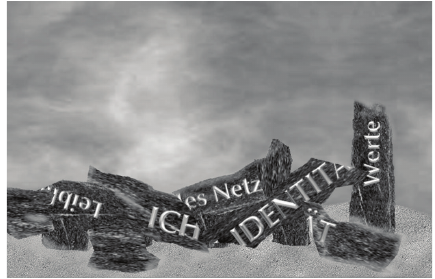
Figure 2: Broken pillars of identity (own